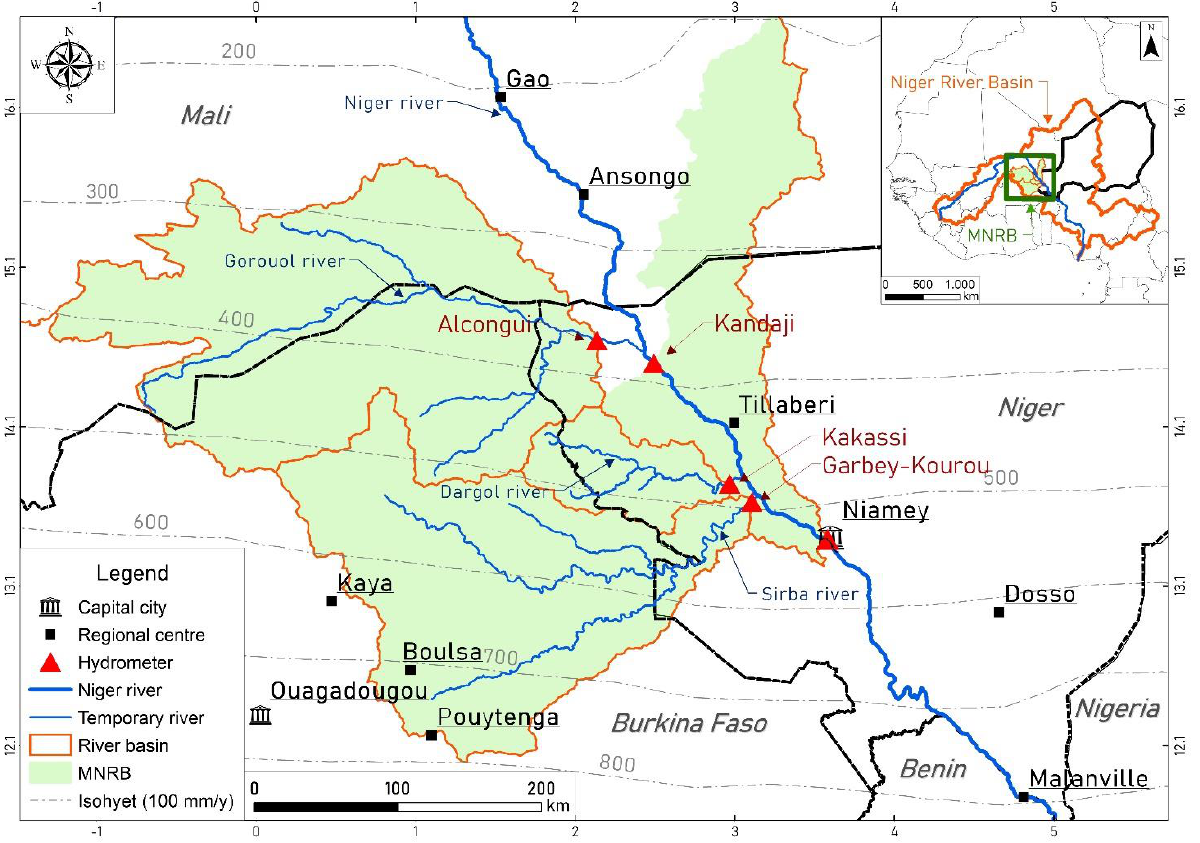
Figure 2. Map of Middle Niger River Basin (MNRB).